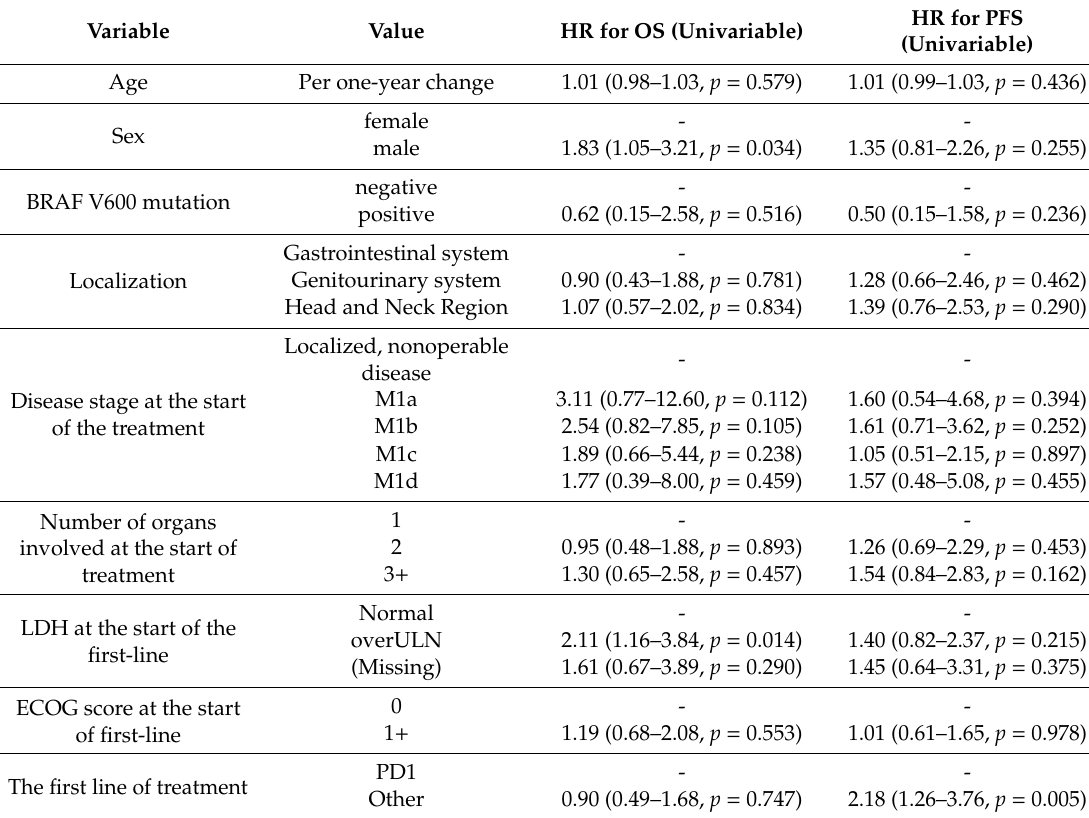
Table 2. Univariable Cox models for overall and progression-free survival. The 95% confidence intervals and p values are listed in